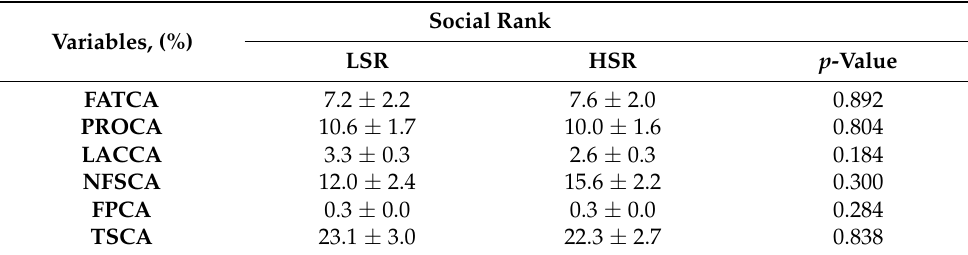
Table 4. Least-square means ± standard error for goat colostrum constituents, fat (FATCA, %), protein (PROCA, %), lactose (LATCA), %), nonfat solids (NFSCA, %), freezing point (FPCA, units), and total solids (TSCA, %) according to the social rank (i.e., LSR and HSR) in crossbred